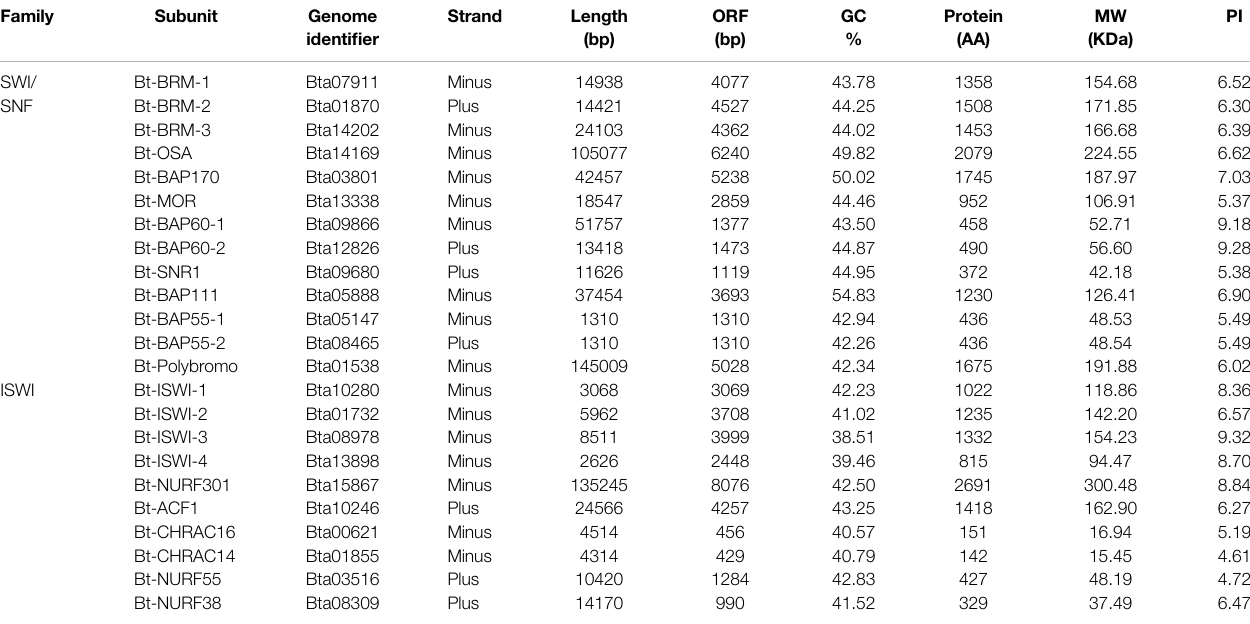
TABLE 1 | Summary of SWI/SNF and ISWI family members found in white fl y genome. Family Subunit Genome identi fi er